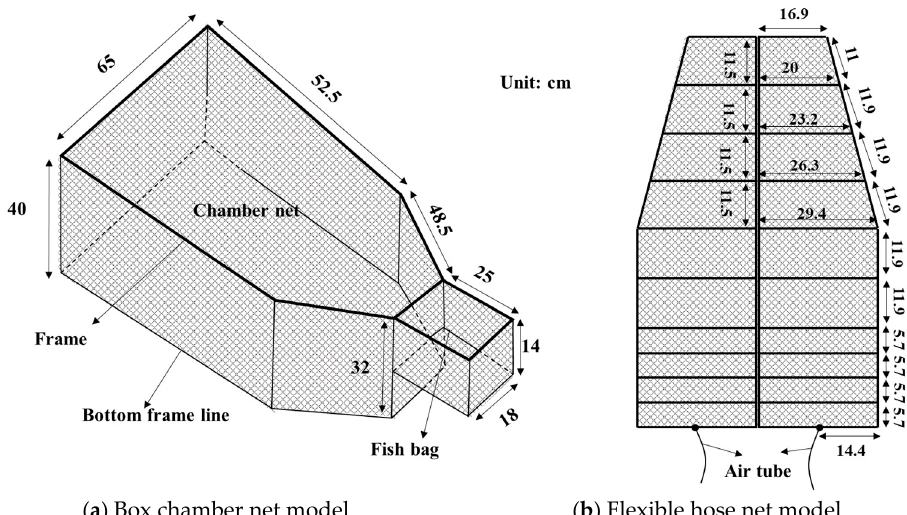
Figure 7. Schematics of the box chamber net and flexible hose net model.